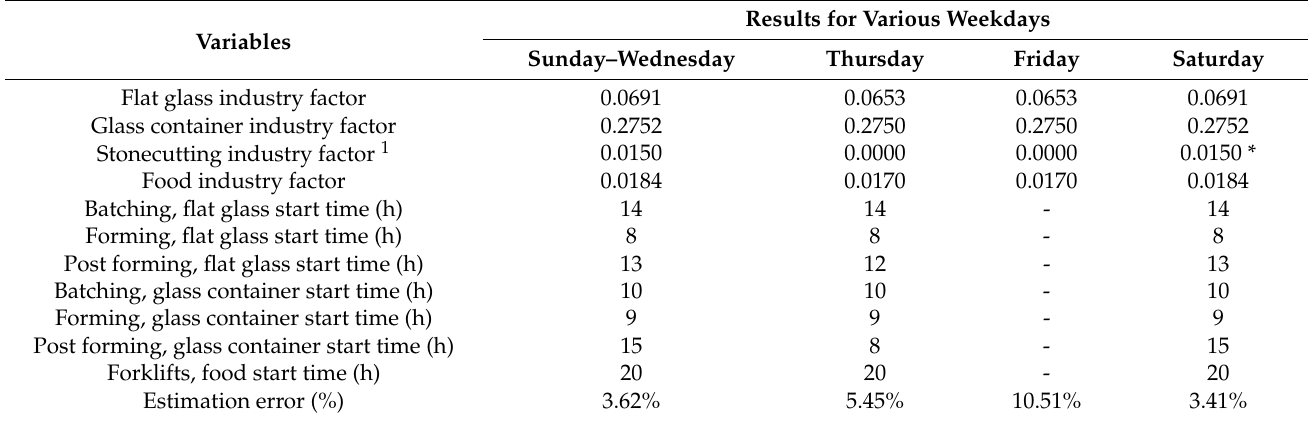
Table 15. The optimum value of the variables for various weekdays in a summer week. Variables